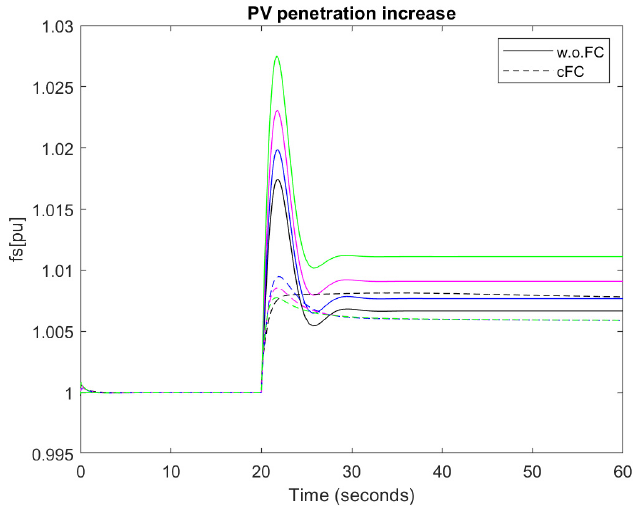
Figure 23. PV penetration increase.